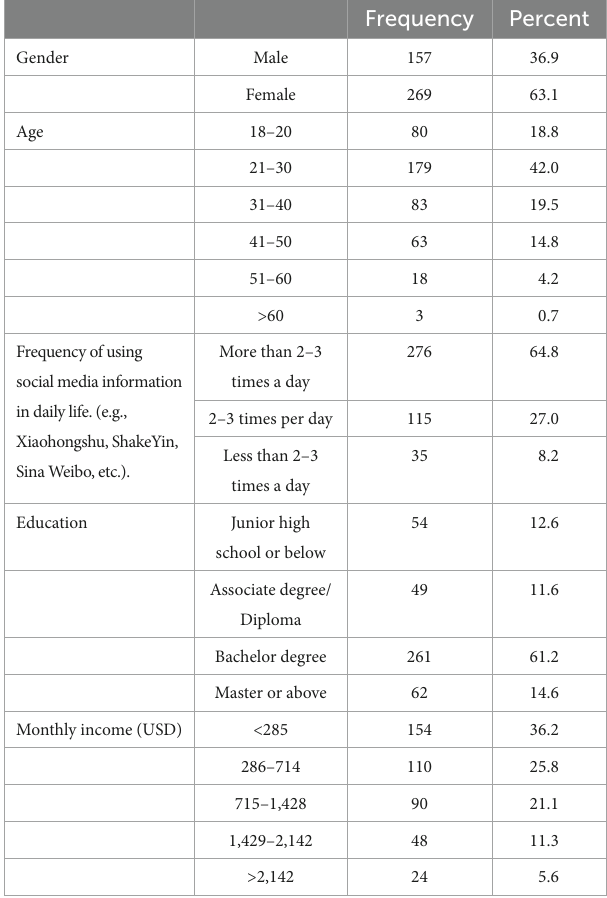
TABLE 1 Respondents’ characteristics ( n =